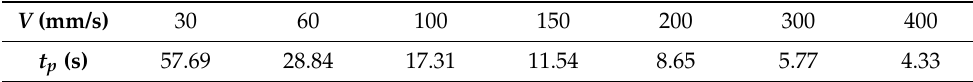
Table 3. Pressure holding time of 5 N/mm laying pressure probe